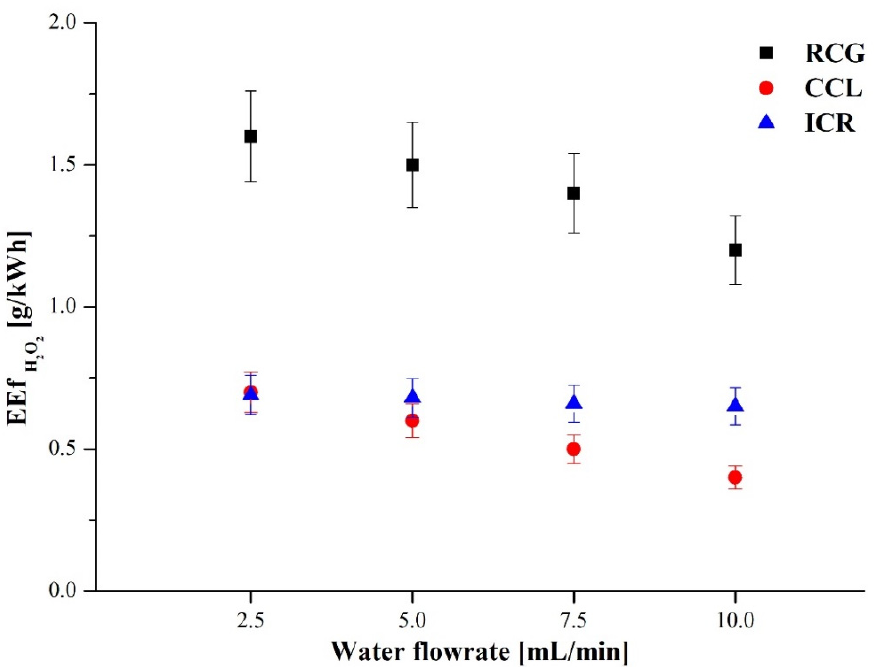
Figure 16. H 2 O 2 production in ICR, CCL, and RCG reactors with Ar.